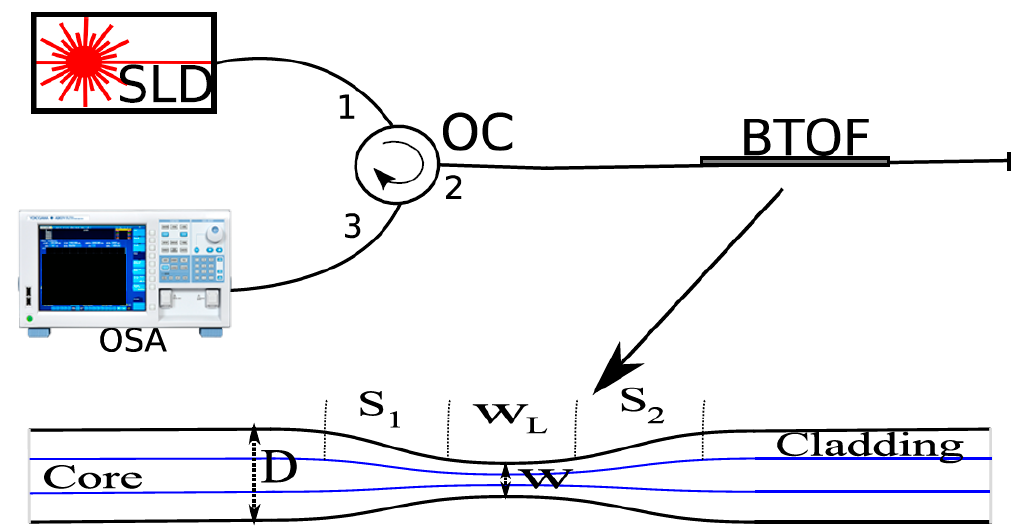
Figure 1. Sketch of the experimental setup (www.yokogawa.com): SLD: super luminescent diode; OSA: optical spectrum analyzer; OC: optical circulator; BTOF: bi-tapered optical fiber. The bottom inset illustrates the BTOF geometry (up- and down-taper sections: S 1 and S 2 ; waist length: W L ; waist diameter: W).